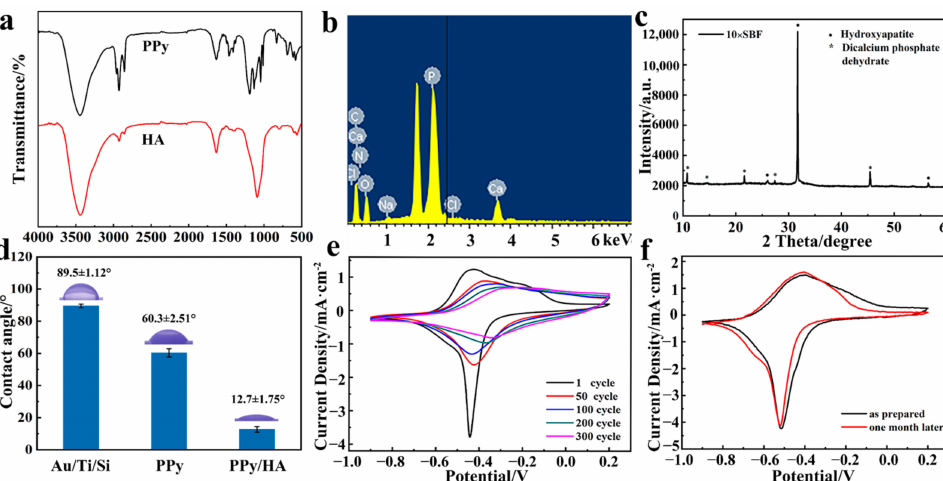
Figure 3. ( a ) FITR spectra of micropatterned PPy and HA in micropatterned PPy/HA composite coatings; ( b ) EDS spectrum of micropatterned PPy/HA composite coatings; ( c ) XRD spectrum of micropatterned PPy/HA composite coatings; ( d ) The water contact angle of different material substrates; ( e ) Cyclic voltammogramms of micropatterned PPy in 0.9% NaCl solution with different cycle turns at the scan rate of 50 mV/s; ( f ) Long-term electroactive stability of micropatterned PPy at the scan rate of 50